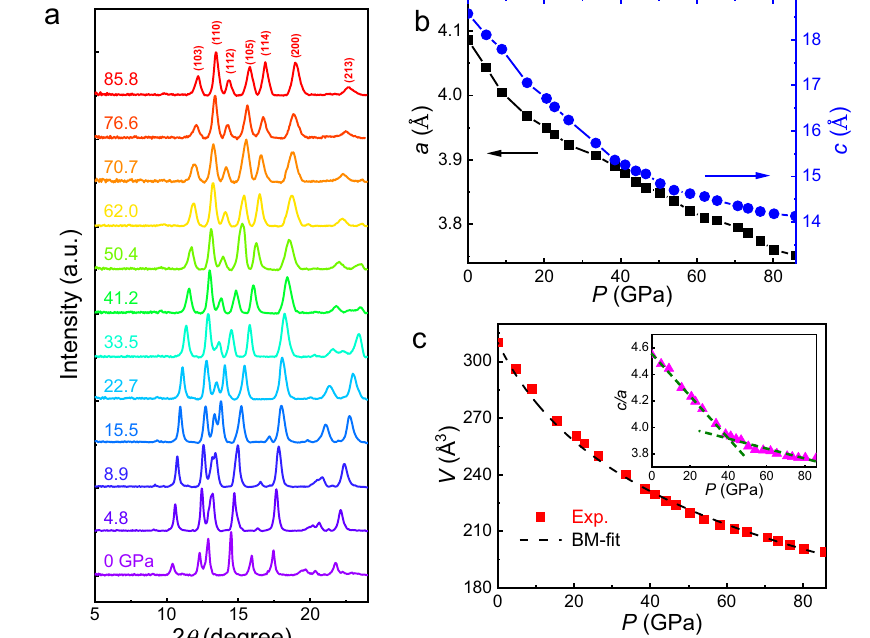
Fig. 3 | High-pressure XRD of La 2 O 3 Fe 2 Se 2 . a XRD patterns of La 2 O 3 Fe 2 Se 2 poly- crystal under high pressure up to 85.8GPa with an incident wavelength λ =0.6199Å. No structural phase transition is detected. b Pressure dependence of the lattice parameters a and c for La 2 O 3 Fe 2 Se 2 . c The derived cell volume as a